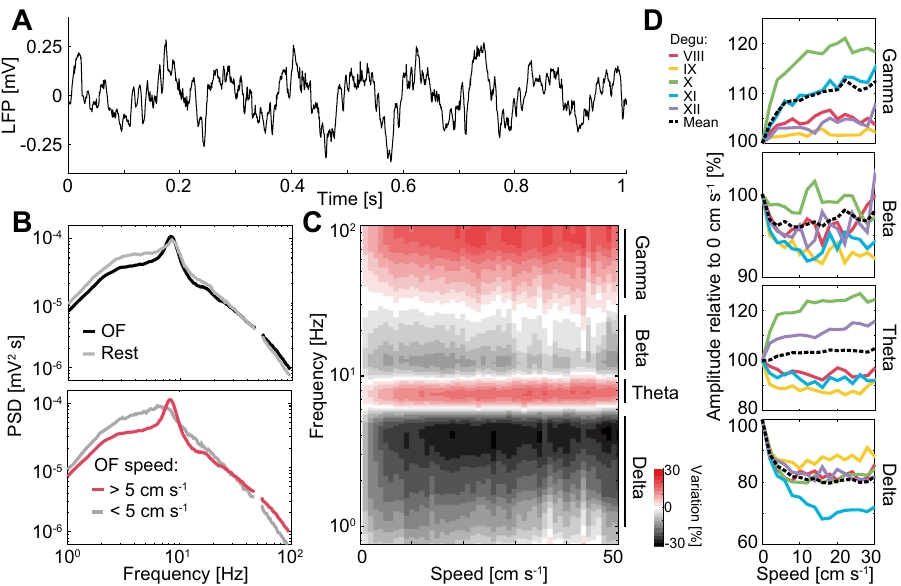
Figure 6. Relation to motion determines frequency bands in the local field potential. ( A ) Representative example of 1 s of local field potential during navigation in the open field. ( B ) Median power spectral density for consecutive 2 s windows. Top: windows in rest (grey) vs open field (black) sessions. Bottom: windows of slow (grey) vs fast (red) mean running speed during open field sessions (cutoff: 5 cm s −1 ). Window around 50 Hz (power line frequency) is removed to improve visualization. ( C ) Mean variation in wavelet transform amplitude relative to the value at 0 cm s −1 for different frequencies and running speeds. Regions of positive and negative relationship with running speed determine frequency bands (indicated) that mirror those found in laboratory rodents. ( D ) Mean variation in Hilbert transform amplitude as a function of speed for the frequency bands identified in ( C ) (from top to bottom: gamma, beta, theta and delta) for the 5 degus recorded in open field experiments (color coded) and overall mean (dashed